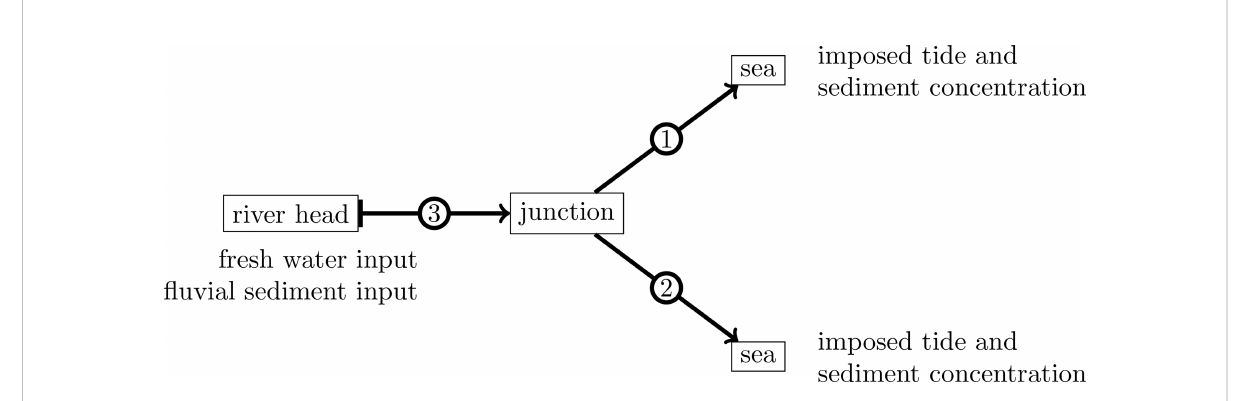
FIGURE 2 Sketch of the three-channel estuarine network considered in this study. Numbers in circles indicate channel